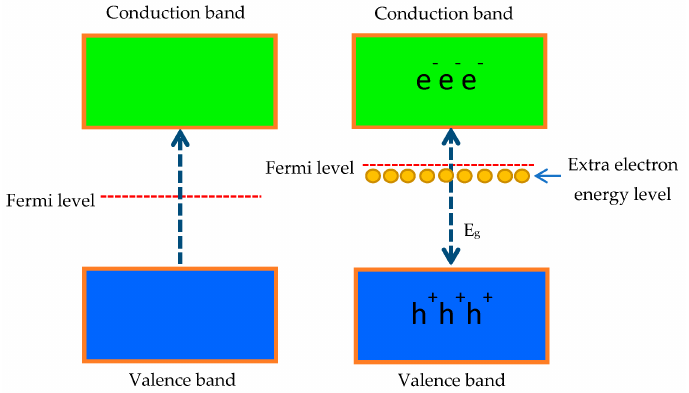
Figure 6. Schematic diagram of transition electron energy level from the valence to conduction band.